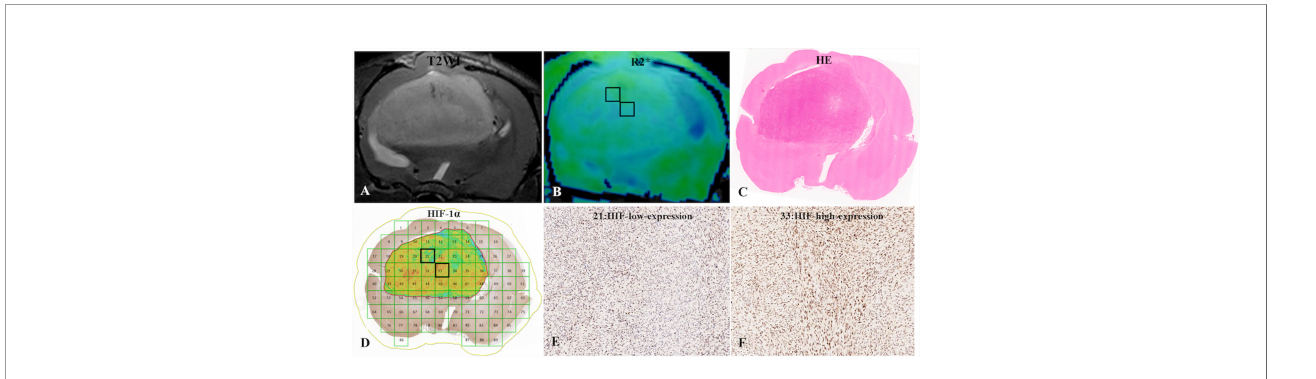
FIGURE 3 | (A) C6-cell glioma tissue was observed in a T2WI image. (B) the post-processing R2* value of c6-cell glioma. (C) H&E staining. (D) ROI locations in the tumor area on the R2* map correspond to 21 and 33 (HIF-1a map), for which the R2* values were 33.50 Hz and 45.87 Hz, respectively, and the HIF-scores were 104.87 and 200.95, respectively. (E, F) Immunohistochemical staining images (× 400) showed low and high expression of HIF-1a in the tumor for ROIs 21 and 33, respectively, on the HIF-1a map.